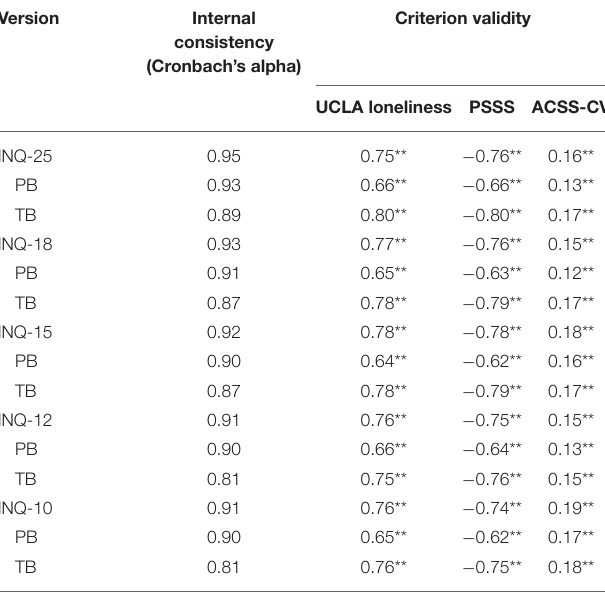
TABLE 3 | Internal consistencies, and correlations between